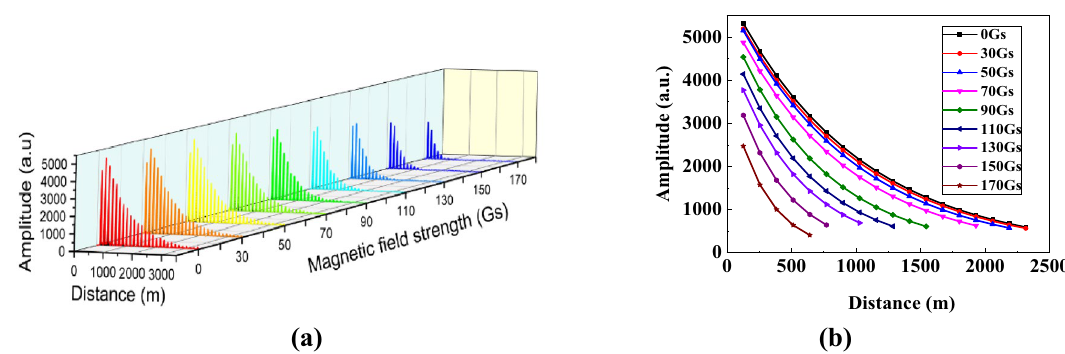
Figure 5. The typical signals measured by the space-domain active FCRD technique. (a) the time-domain differential interference signal; (b) the corresponding ringdown transient in the space